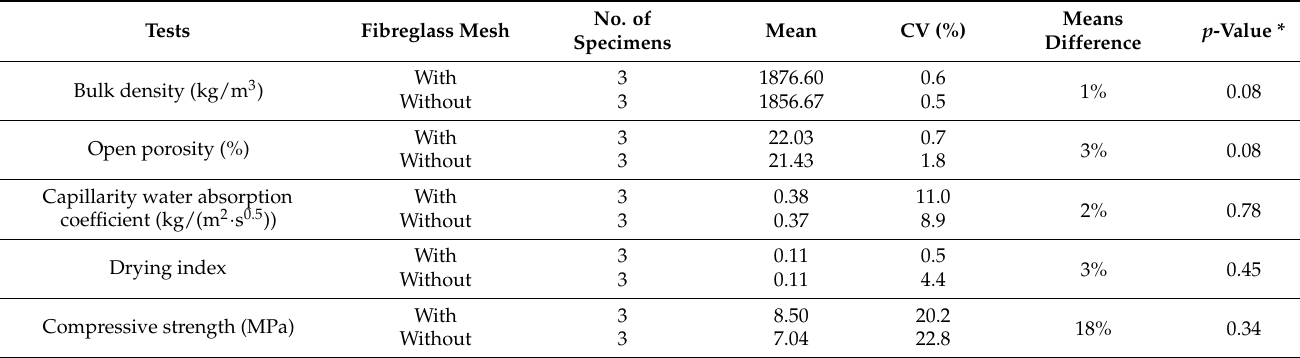
Table 7. Hydraulic lime mortar applied to the concrete slab substrate.